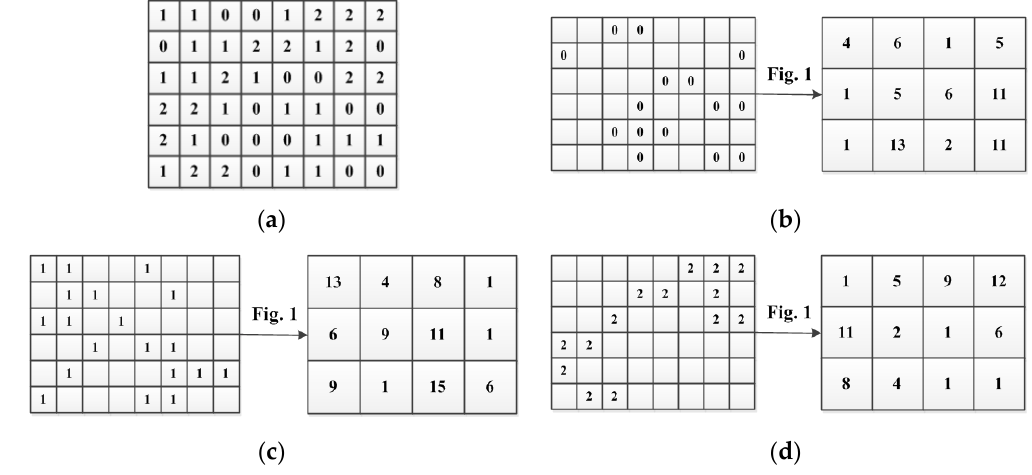
Figure 2. Example of traversing color layers with the proposed texture elements. ( a ) Quantized saturation in the image; ( b ), ( c ), and ( d ) are traversing the color layer of quantized values 0, 1, and 2, respectively.